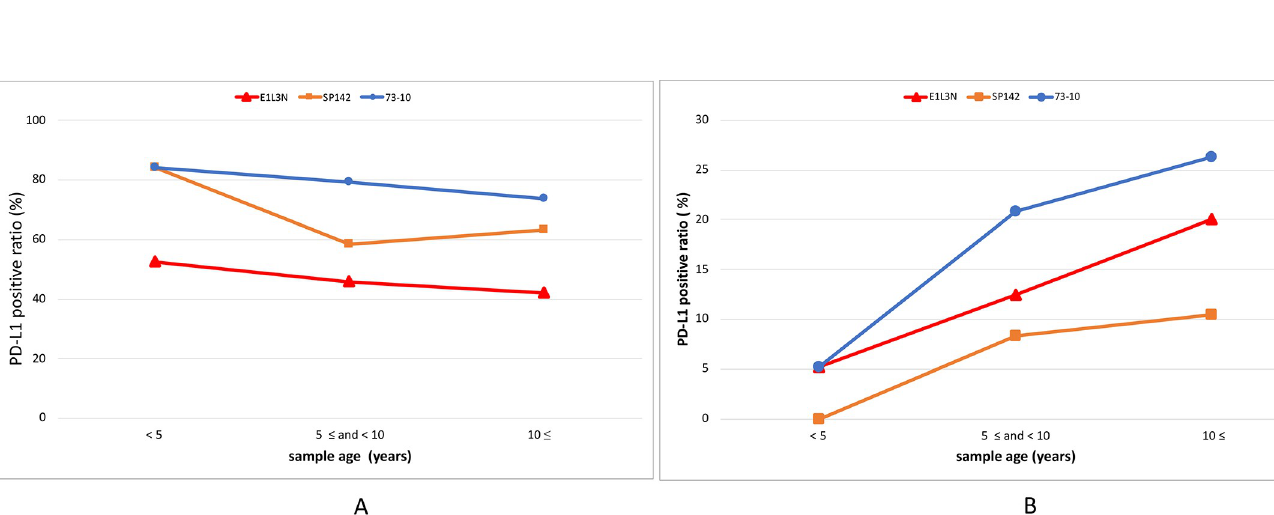
PLOS ONE | https://doi.org/10.1371/journal.pone.0257860 September 24, 2021 10 /